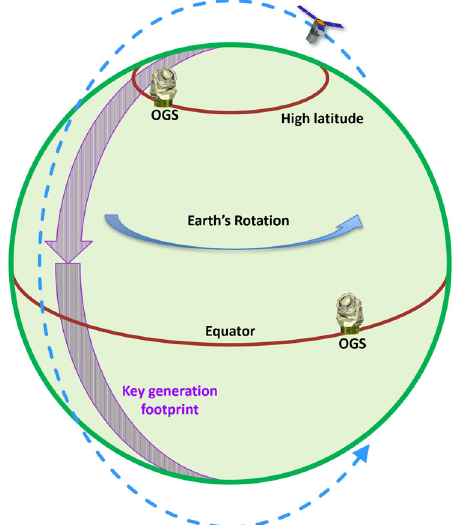
Fig. 9 Satellite key generation footprint. We consider a satellite in SSO with inclination 98°. The width of the striped purple